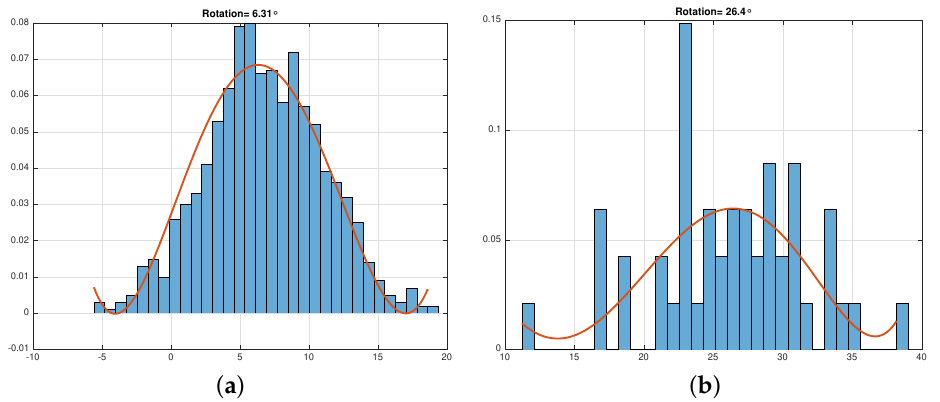
Figure 7. Phase offset histogram is unimodal for small f d T , ( a ). Longer data blocks cause phase smearing illustrated by a broad phase angle histogram, ( b ). ( a ) Small phase offset, 6 ◦ , ( b ) Large phase offset, 26 ◦